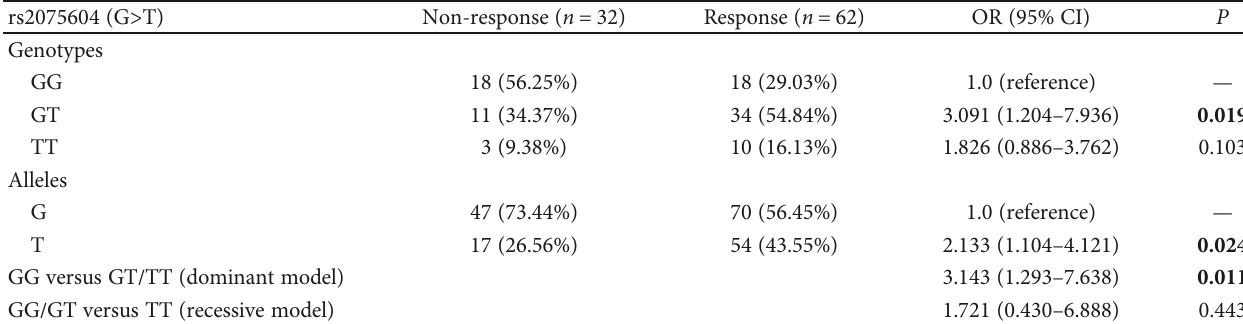
Table 4: Association between STK11 rs2075604 genetic polymorphism and metformin e ffi cacy in T2DM patients (adjusted for age, gender, and BMI).